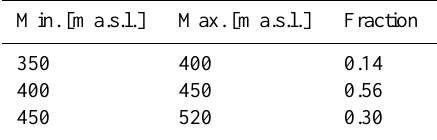
Table A2. Hypsometric information for the Norrsj¨on